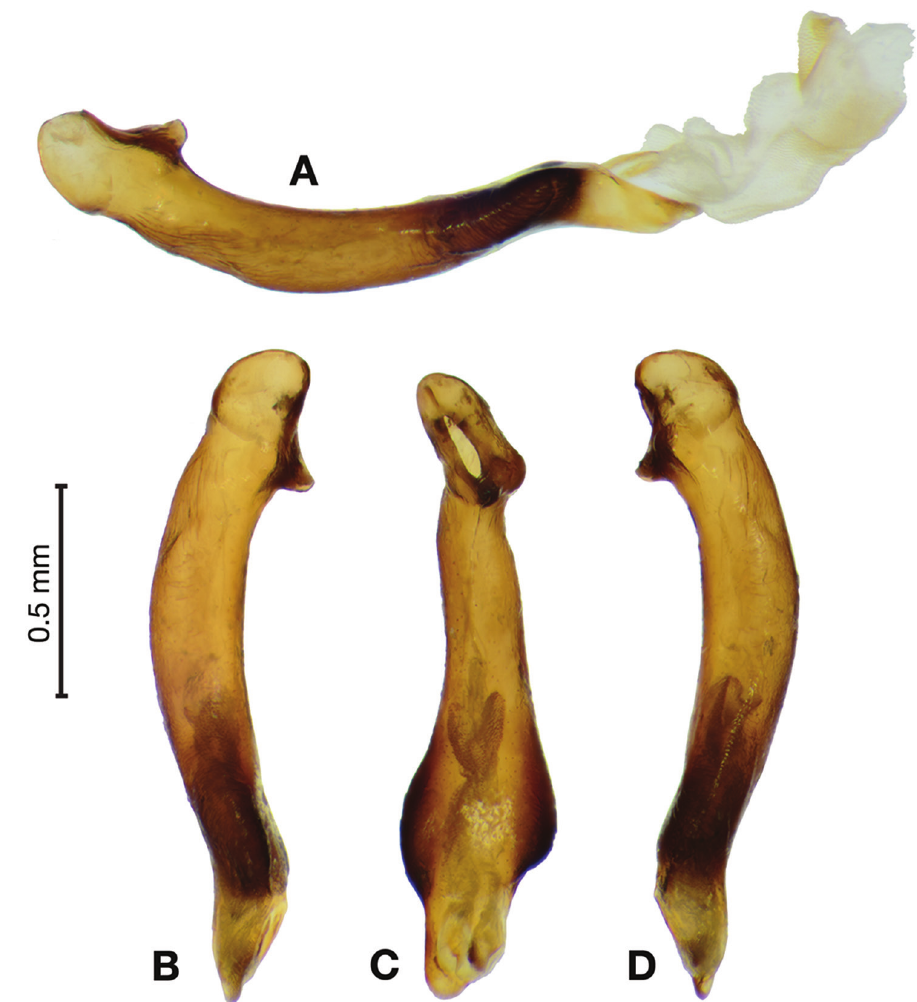
Figure 18. Digital images of male genitalia of Brachichila hypocrita Chaudoir. A left lateral aspect, en- dophallus everted B right lateral aspect C ventral aspect D left lateral